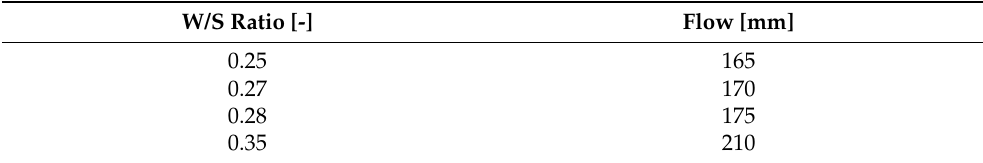
Table 1. Paste flow at different water/slag